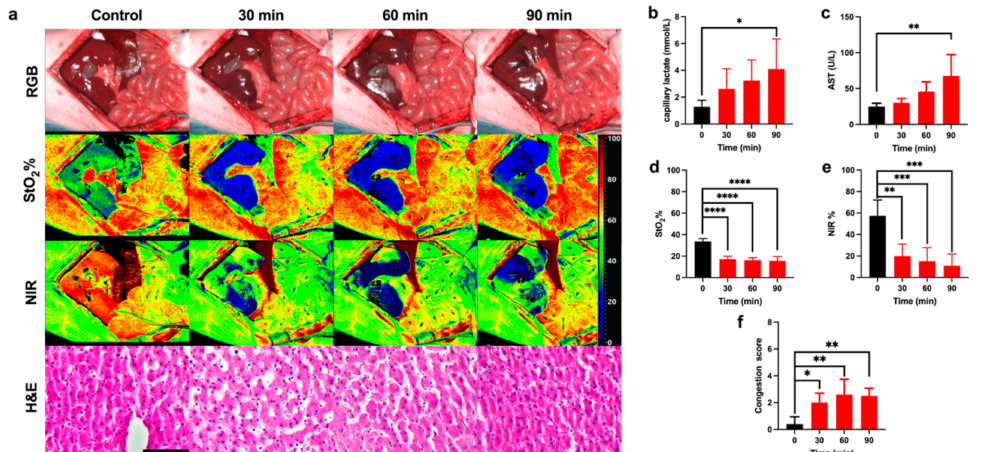
Figure 2. Ischemic phase evaluation. ( a ) RGB, HSI, and H&E images of the liver during the ischemic phase. Hyperspectral images of StO 2 % and NIR% showed an oxygenation decrease during the ischemic phase. H&E images show the gradual congestion increase. ( b , c ) Capillary lactate ( n = 5) and AST ( n = 4) levels indicated a gradual liver impairment. ( d , e ) Both preset software parameter indexes of the oxygenation showed a significant decrease in oxygen levels. ( f ) The histopathological score of congestion was significant during the ischemic phase. Data are compared to the control, ns p > 0.05, * p ≤ 0.05, ** p ≤ 0.01, *** p ≤ 0.001, **** p ≤ 0.0001 ( n = 5). Histology photos were taken with a Leica DM2000 LED microscope, magnification 40 × , scale bar 100 µ